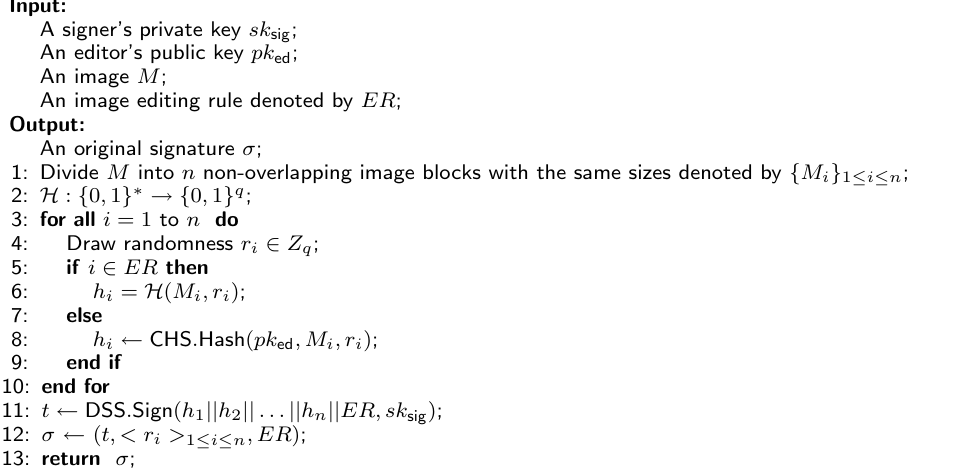
Algorithm 2 OrigAuth: The original authentication